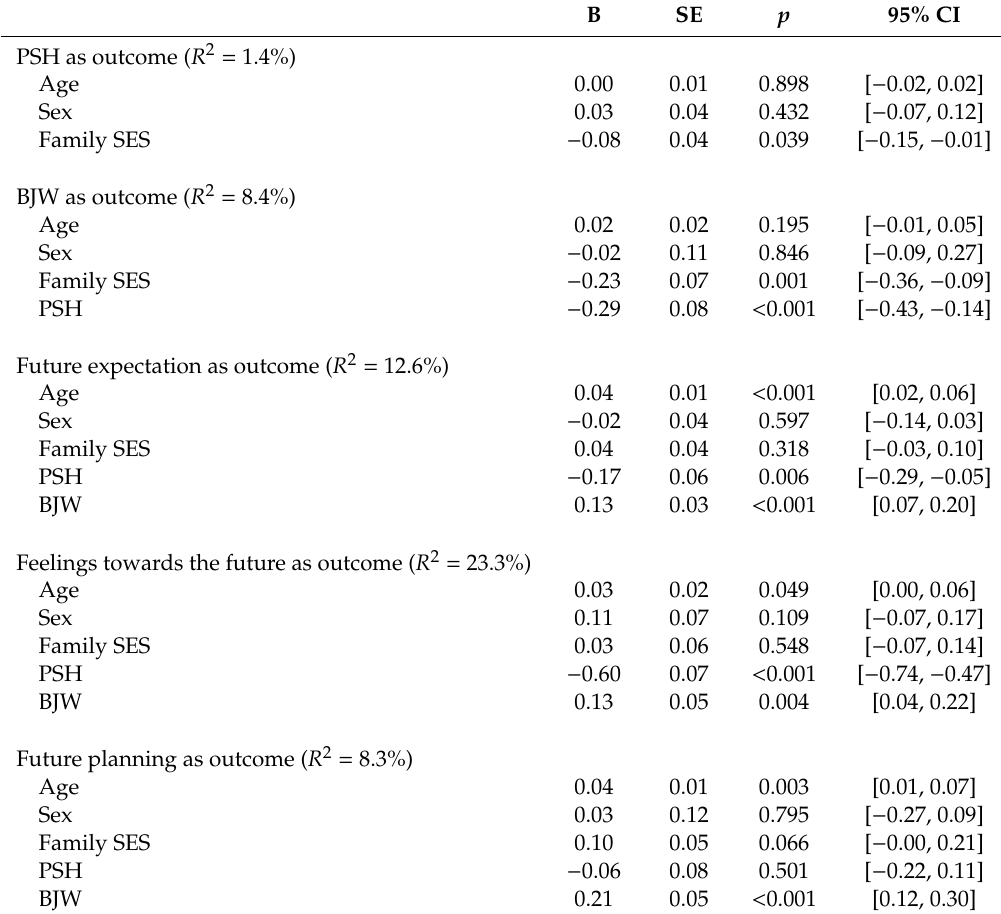
Table 2. The associations among perceived social hardship, belief in a just world, and future orientation. B SE p 95%